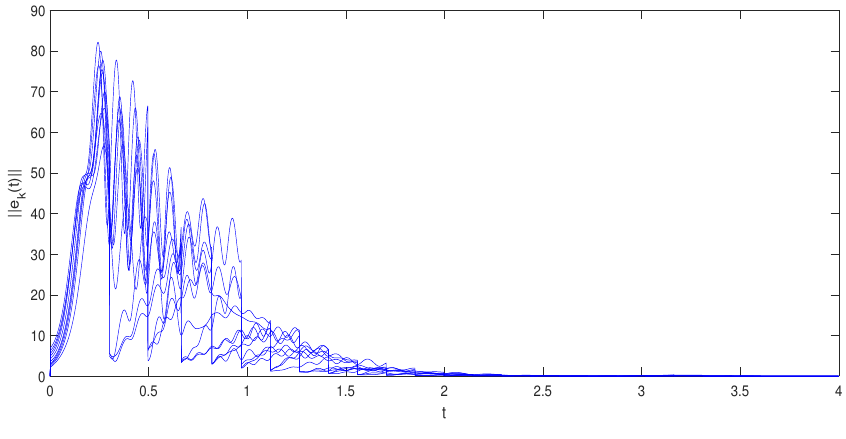
Figure 2. The orbits of the norm of synchronization errors (cid:107) e k ( t ) (cid:107) .